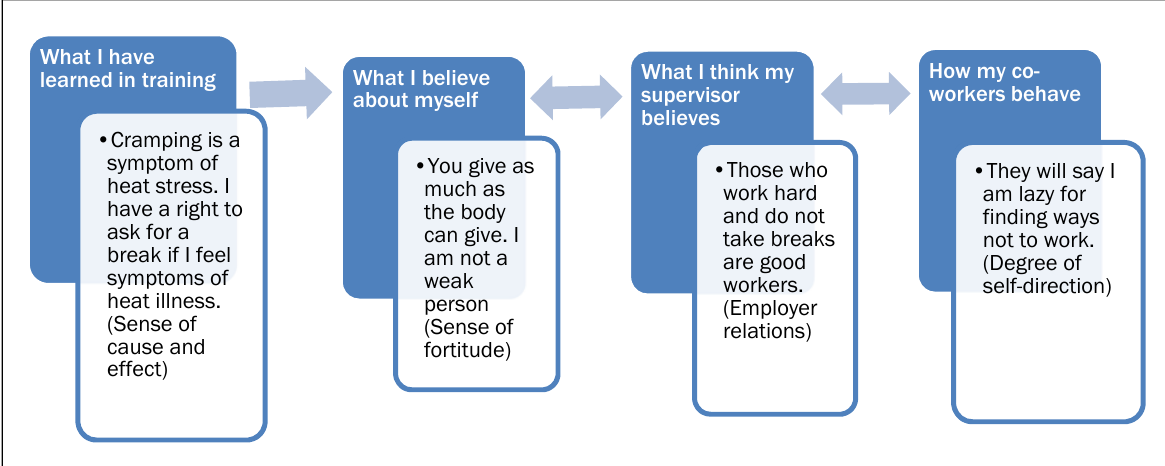
Figure 6. Relationship Among Beliefs, Self-perceptions, and Learning as Expressed in Focus Group